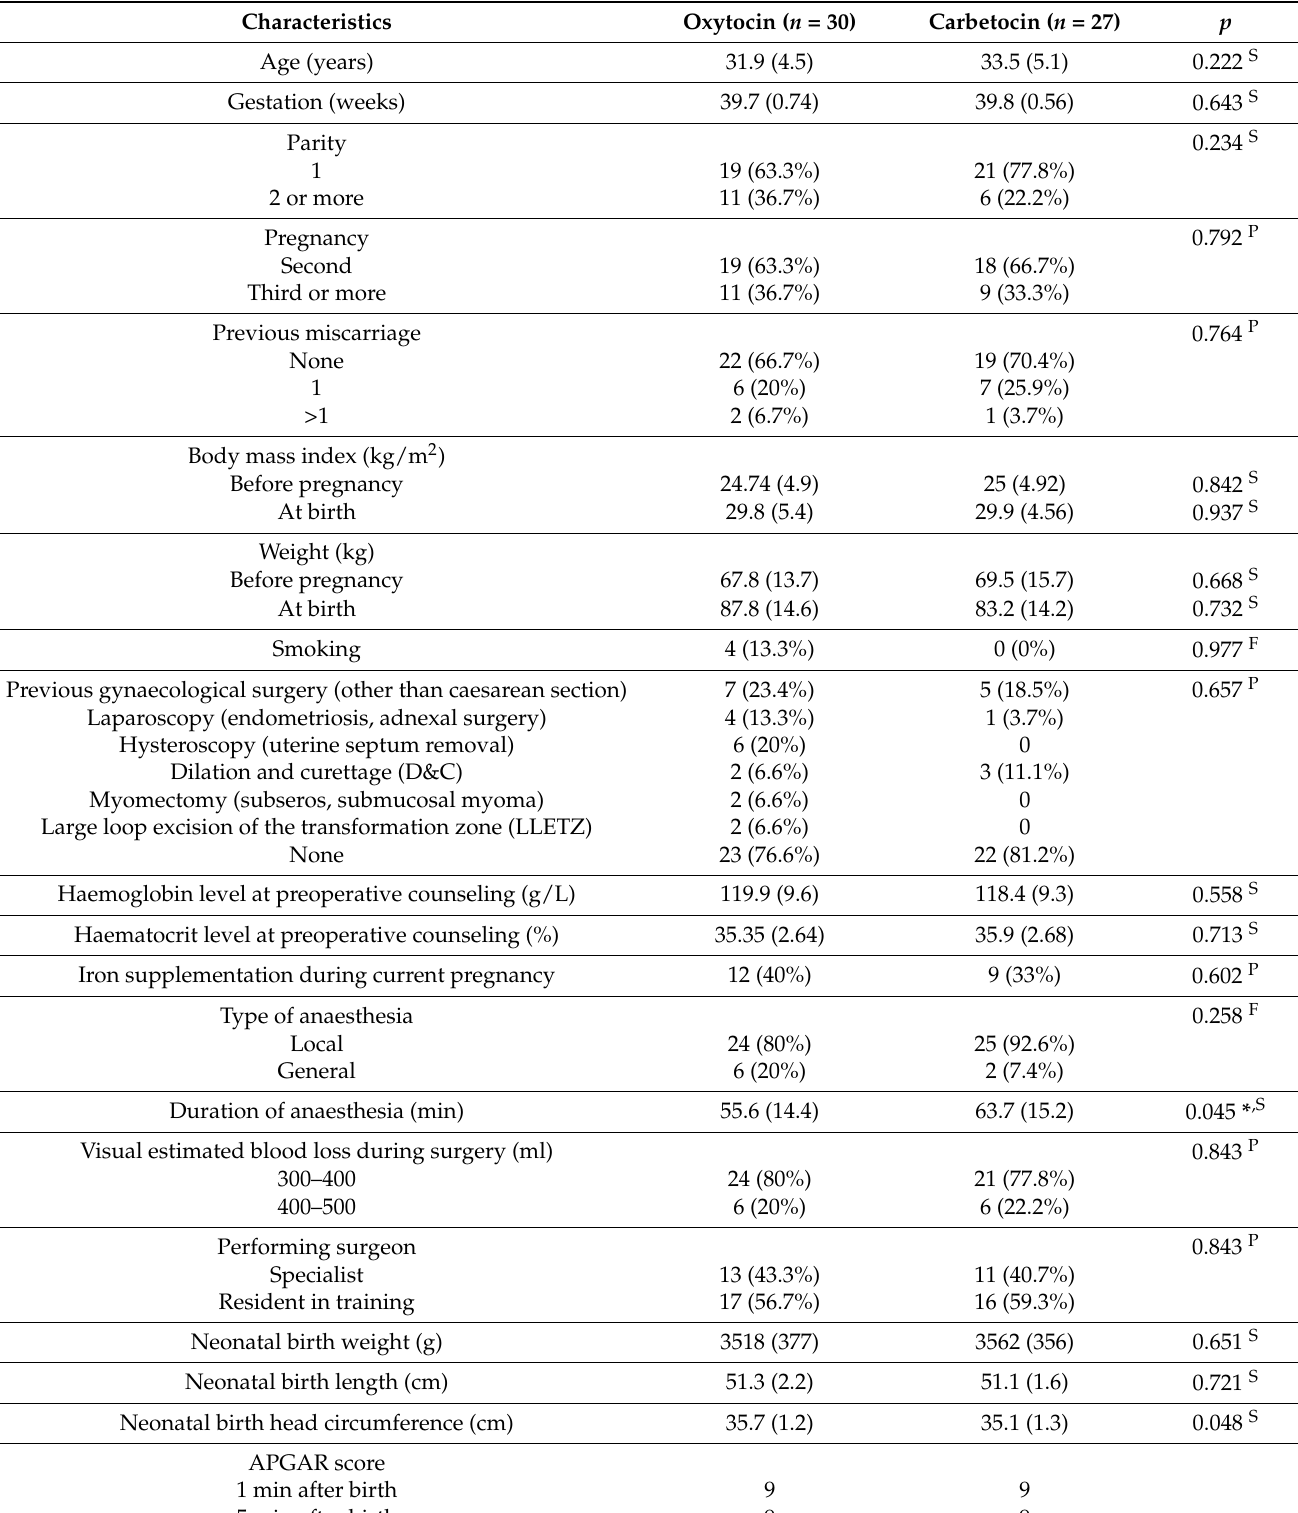
Table 1. Background characteristics of the women (demographic data, reproductive data, perinatal data, surgery details (anaesthesia, surgeon, visual blood loss), pre-surgery laboratory